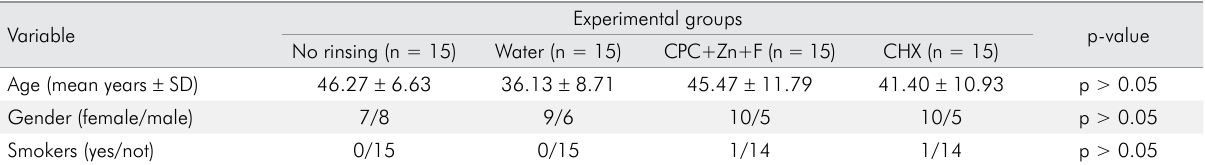
Figure 3. Bar chart of the mean total colony-forming units (CFUs) in the volunteer, clinician, support board and all locations according to experimental groups. The significance of differences among groups was assessed using Kruskal-Wallis and Dunn test (different capital letters indicate significant differences between test and control groups, p < 0.05).